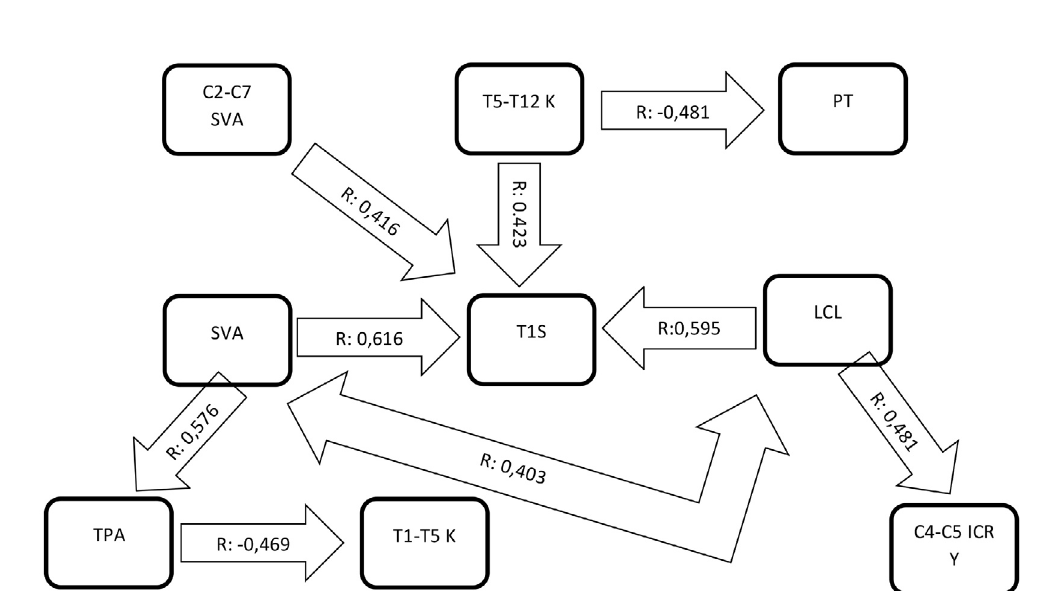
Fig. 4: Spearman correlation analysis of variables. Note that the T1 slope acts as a keystone. T1S: T1 slope, LCL: Lower cervical lordosis, ICR: Instantaneous center of rotation, PT: Pelvic tilt, SVA: Sagittal vertical axis, TPA: T1 Pelvic angle, T1-T5 K: T1-T5 Kyphosis